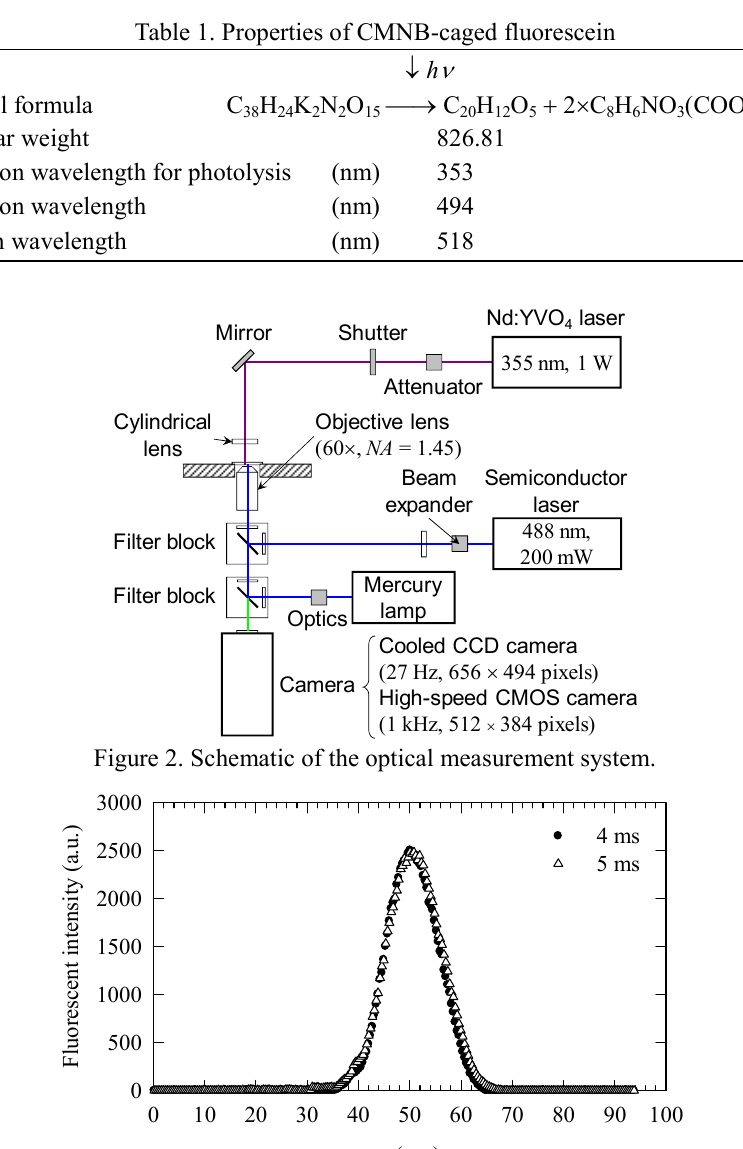
Figure 3. Fluorescent intensity profiles of the uncaging event by the pulsed UV laser. The thickness of the laser sheet was estimated to be 15 µ